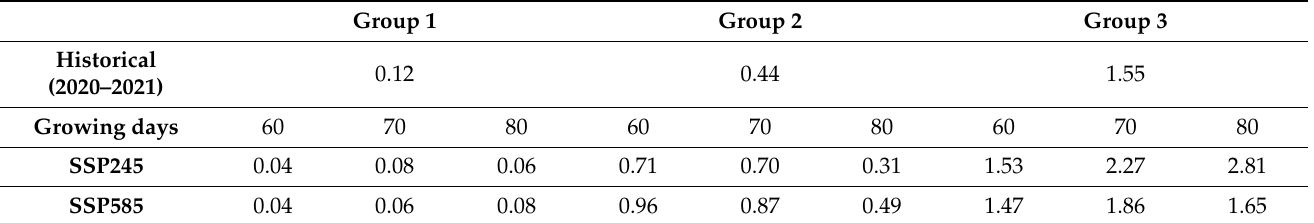
Table 7. Unit price of Chinese cabbage (USD/kg) under two climate change pathways (SSP245 and SSP